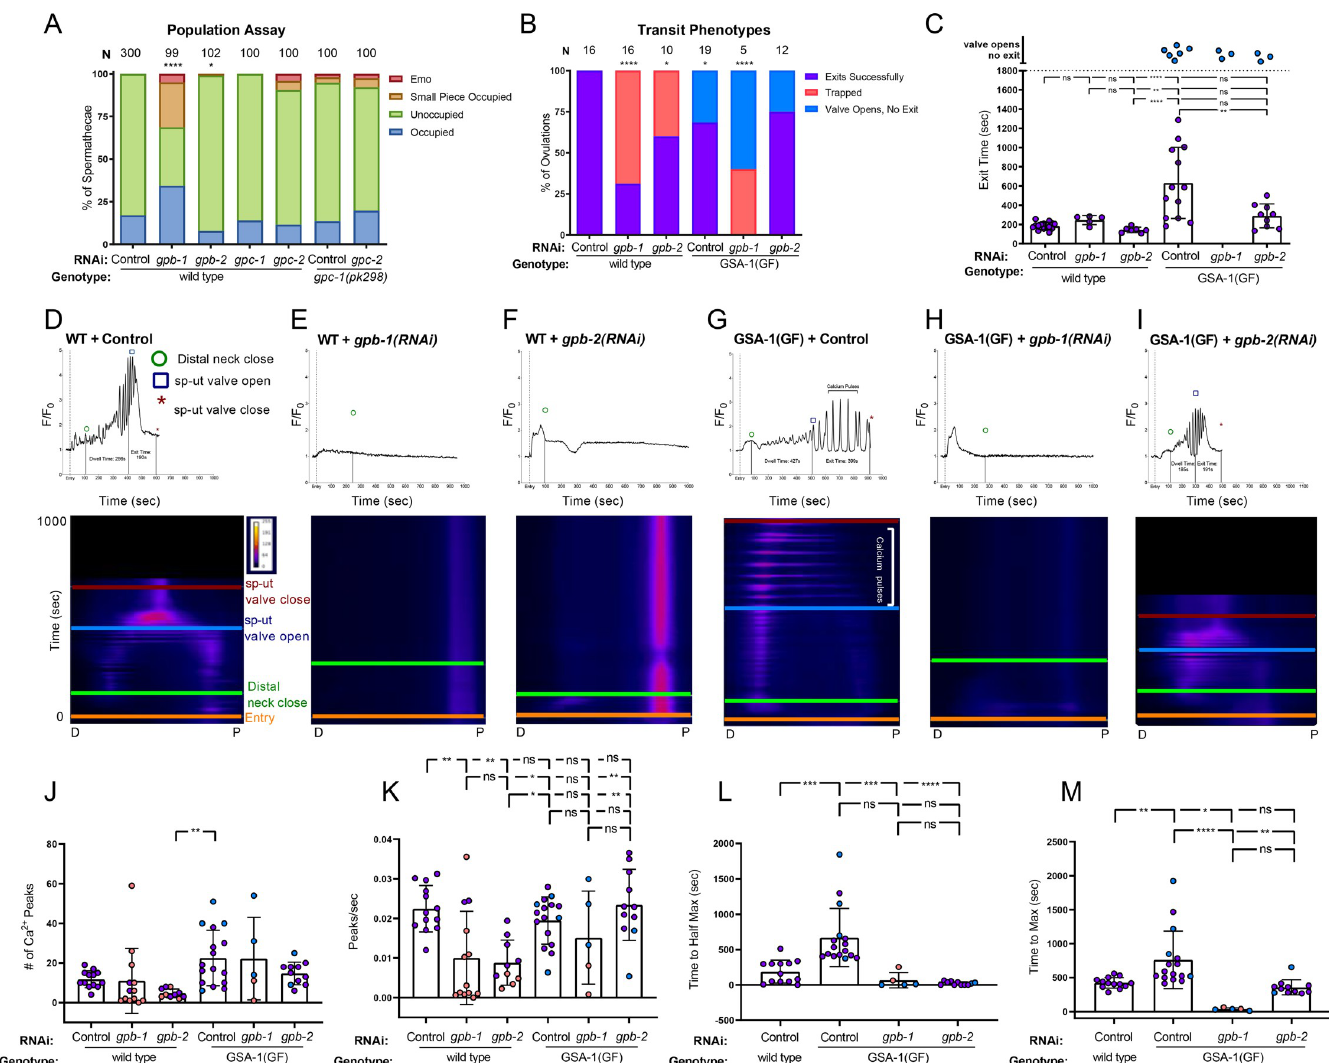
Fig 6. Heterotrimeric G-protein beta subunits GPB-1 and GPB-2 regulate Ca 2+ signaling and spermatheca contractility. (A) Population assay of wild type young adults grown on control RNAi, gpb-1(RNAi) , gpb-2(RNAi) , gpc-1(RNAi) , and gpc-2(RNAi) and gpc-1(pk298) grown on control RNAi and gpc-2(RNAi) . Spermathecae were scored for the presence or absence of an embryo (occupied or unoccupied), presence of a fragment of an embryo (small piece occupied), or the presence of endomitotic oocytes in the gonad arm (emo) phenotypes. The total number of unoccupied spermatheca was compared to the sum of all other phenotypes using the Fisher’s exact t -test. N is the total number of spermathecae counted. (B) Transit phenotypes of the ovulations in wild type animals treated with control RNAi, gpb-1 (RNAi) and gpb-2(RNAi) , and GSA-1(GF) animals treated with control RNAi, gpb-1(RNAi) , and gpb-2(RNAi) were scored for successful embryo transits through the spermatheca (exits successfully), failure to exit (trapped), and the situation in which the sp-ut valve opens, but the embryo does not exit (valve opens, no exit). Color coding of the data points corresponds to the transit phenotypes in B. For transit phenotype analysis, the total number of oocytes that exited the spermatheca successfully was compared to the sum of all other phenotypes. Fisher’s exact t -tests were used for both population assays and transit phenotype analysis. (C) Exit time of movies in B were compared using One-way ANOVA with a multiple comparison Tukey’s test. Representative normalized Ca 2+ traces and kymograms of movies in B (D-I) are shown with time of entry, distal neck closure, and time the sp-ut valve opens and closes indicated. Levels of Ca 2+ signal were normalized to 30 frames before oocyte entry. Kymograms generated by averaging over the columns of each movie frame (see methods). Refer to S3A, S3E, S3F Fig and S5A, S4C, S4D Figs for additional Ca 2+ traces, and S6D and S6E Fig and S9B and S9C Fig for additional kymograms. (J-M) Color coding of the data points corresponds to the transit phenotypes in A. (J) The number of Ca 2+ peaks and (K) the peaks per second was determined for wild type animals treated with control RNAi, gpb-1(RNAi) and gpb-2(RNAi) , and GSA-1(GF) animals treated with control RNAi, gpb-1(RNAi) , and gpb-2(RNAi) . The amount of time after oocyte entry required to reach either the (L) half maximum or (M) maximum Ca 2+ signal was quantified for wild type animals treated with control RNAi, GSA-1(GF) animals treated with control RNAi, gpb-1(RNAi) , and gpb-2(RNAi) . These values were compared using one-way ANOVA with a multiple comparison Tukey’s test. and compared using Fishers exact t -test. Stars designate statistical significance ( ���� p < 0.0001, ��� p < 0.005, �� p < 0.01, � p < 0.05).